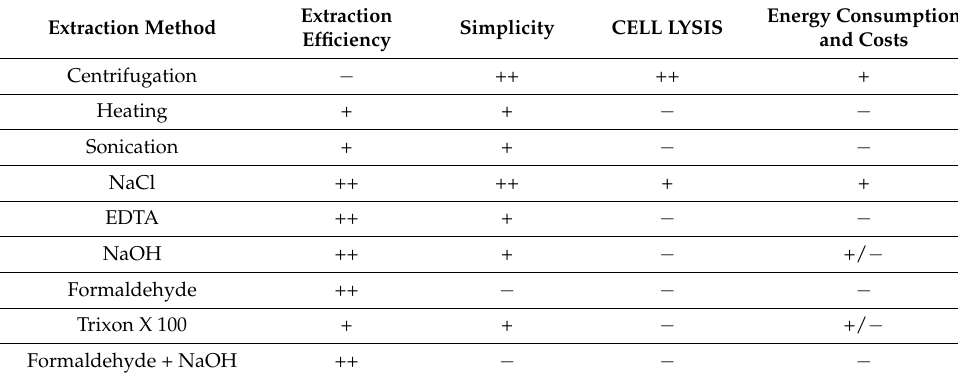
Table 4. Limitations and advantages of selected EPS extraction methods (“ − ” poor, “+” good, “++” very good, “+/ − ”